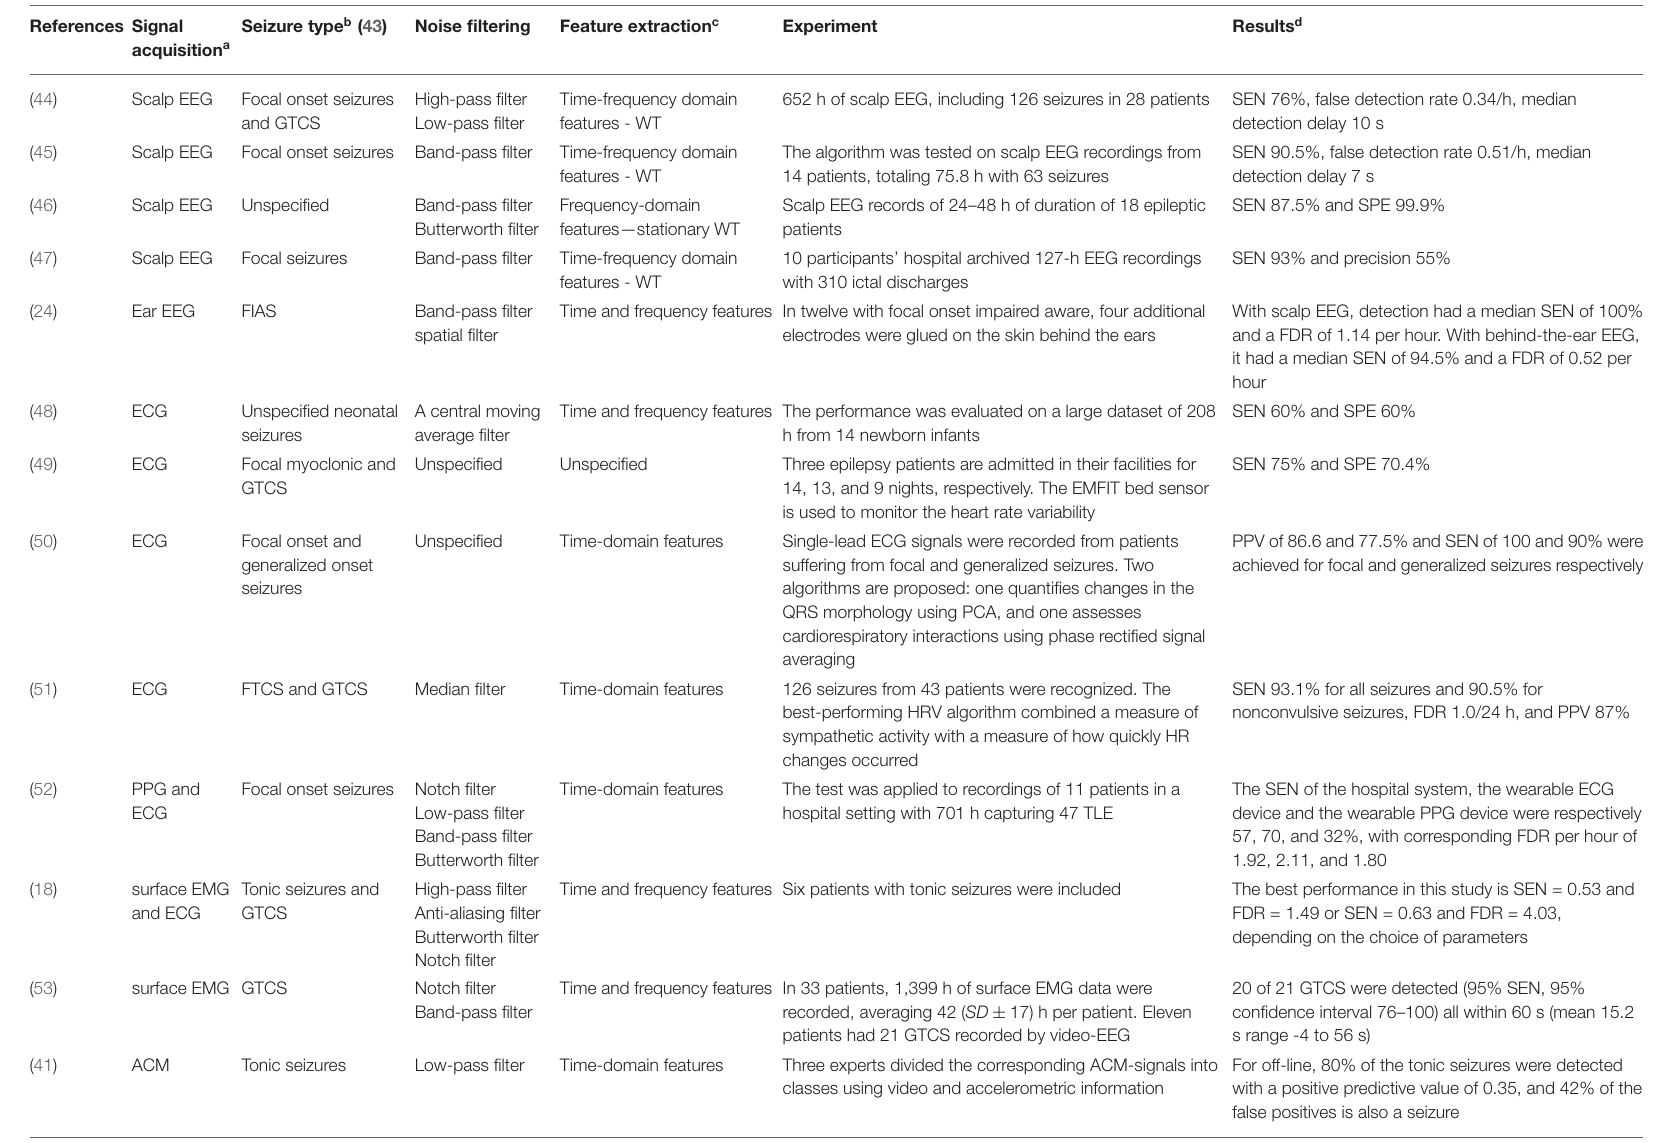
TABLE 1 | Seizure detection depending on the signal types. References Signal Seizure type b acquisition a